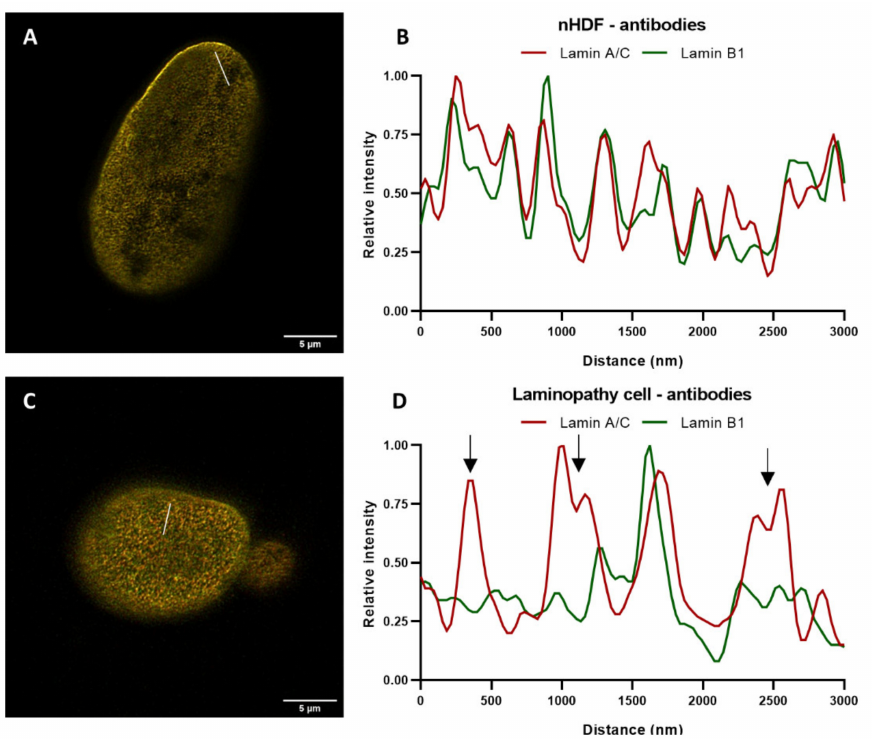
Figure 11. Comparison of nuclear staining patterns between one nHDF ( A ) and a laminopathy patient dermal fibroblast with an LMNA c.1130G>T (p.(Arg377Leu)) variant ( C ). Both nuclei were stained with antibodies against lamin A/C and B1. The corresponding intensity plots of ROIs (straight white lines) in ( A , C ) are displayed in ( B , D ), respectively. Scale bars: 5 µ m. ( B , D ) Plot profile of lamins’ intensities in STED microscopy images, normalized to maximum value. Red curves show the relative intensity of lamin A/C, green curves the relative intensity of lamin B1. Arrows in ( D ) indicate regions with major segregations between the lamin A/C and lamin B1 network, that are found to a much less extent in the nHDF nucleus ( B